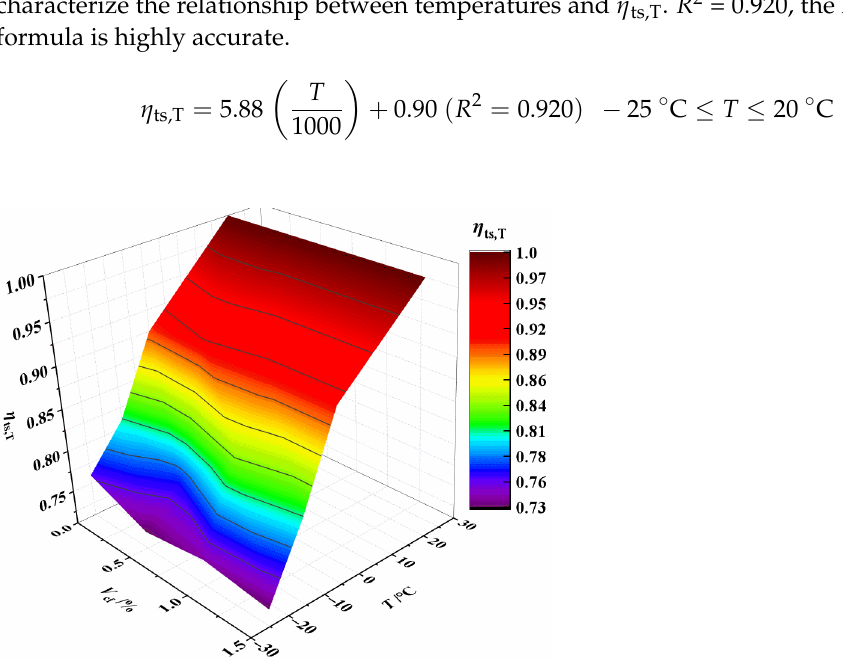
Figure 18. Relationship η ts,T vs. T and V cf